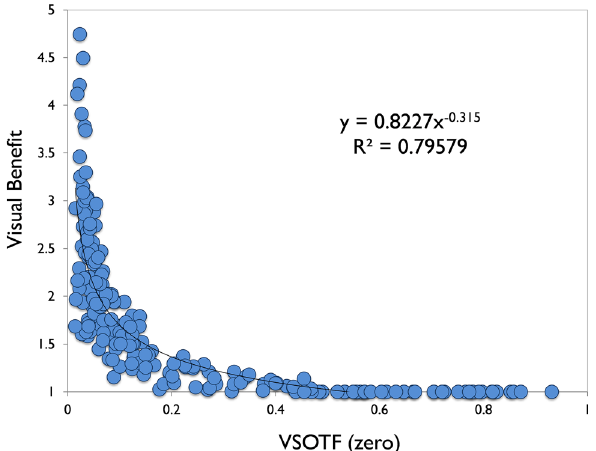
Figure 4. VSOTF (zero defocus and astigmatism) vs. Visual benefit, defined as VSOTF (optimized defocus and astigmatism) divided by VSOTF (zero defocus and astigmatism).